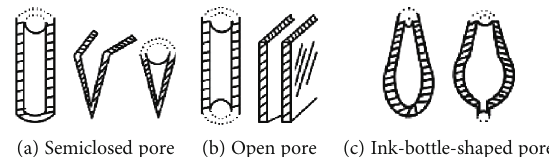
Figure 6: Classi fi cation of pore shapes corresponding to the mercury injection